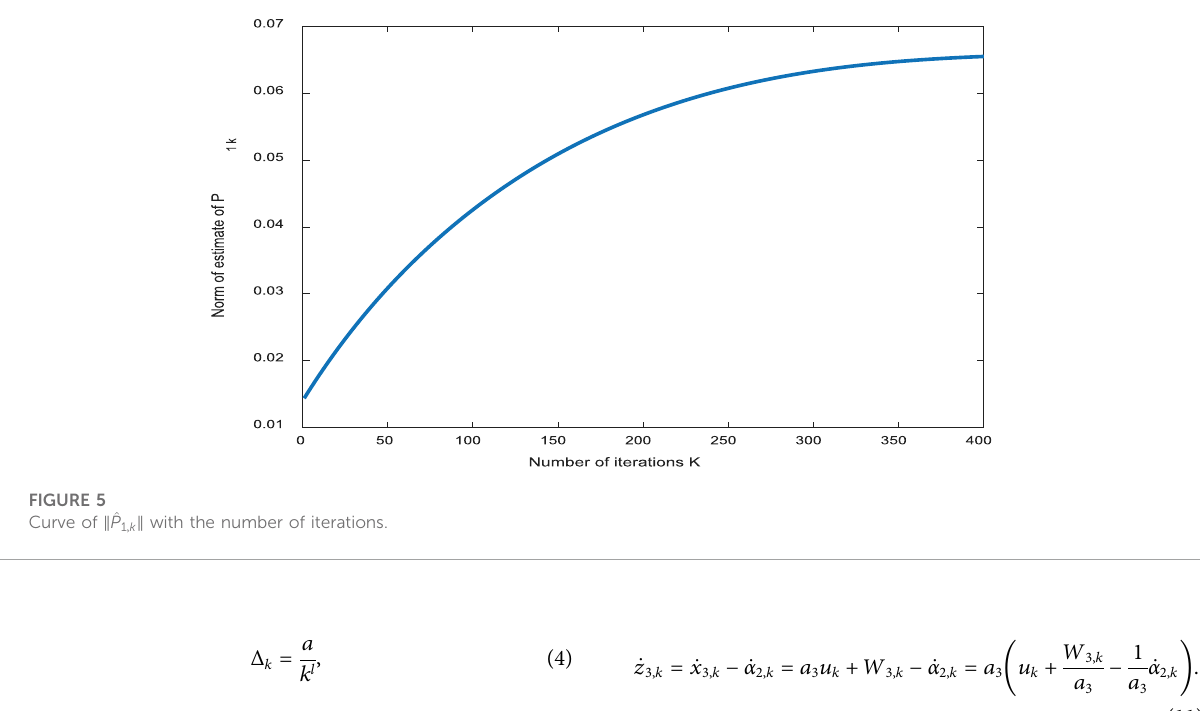
FIGURE 5 Curve of (cid:3) ^ P 1 , k (cid:3) with the number of